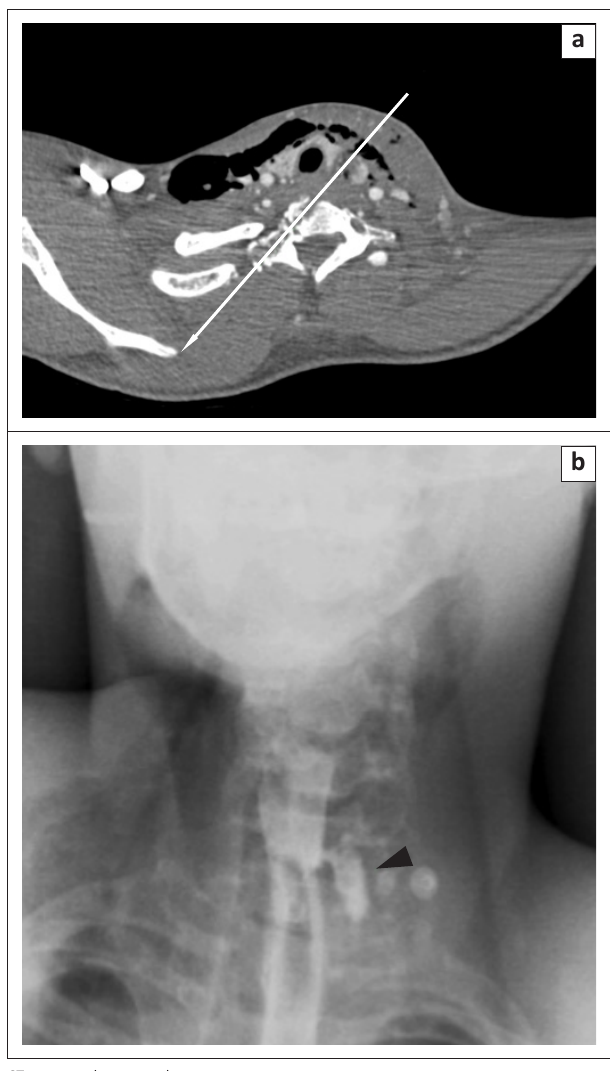
CT, computed tomography. FIGURE 6: Axial CT image (a) demonstrates a bullet tract (arrow) passing through the left thyroid lobe, crossing the midline and fracturing the right-sided elements of the first thoracic vertebra, with a high index of suspicion for oesophageal injury. The contrast swallow confirms an oesophageal injury with a left sided contrast leak (arrowhead, b).